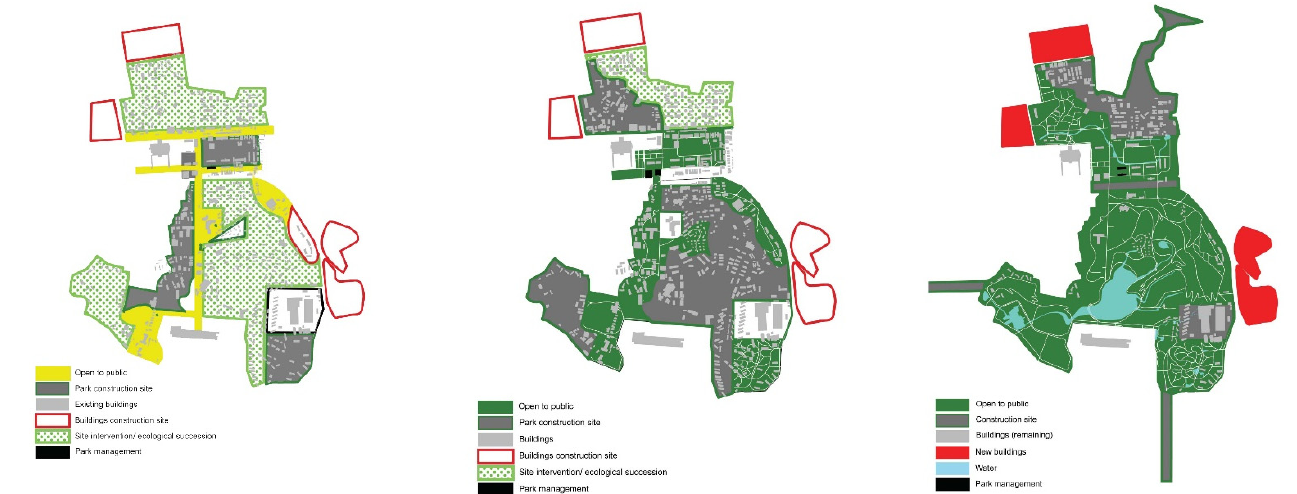
Figure 7. Phasing plan for Yongsan Park (sources: West 8 and Iroje et al., [56]).